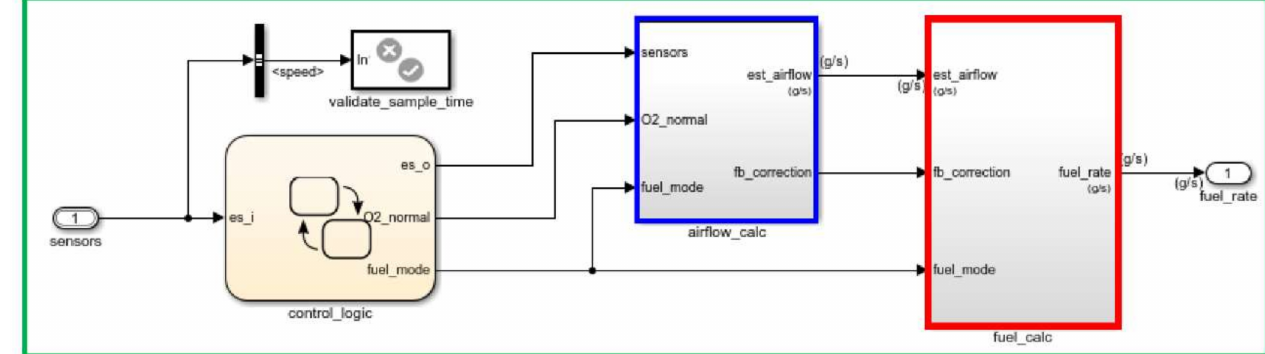
Figure 9. Fuel rate control